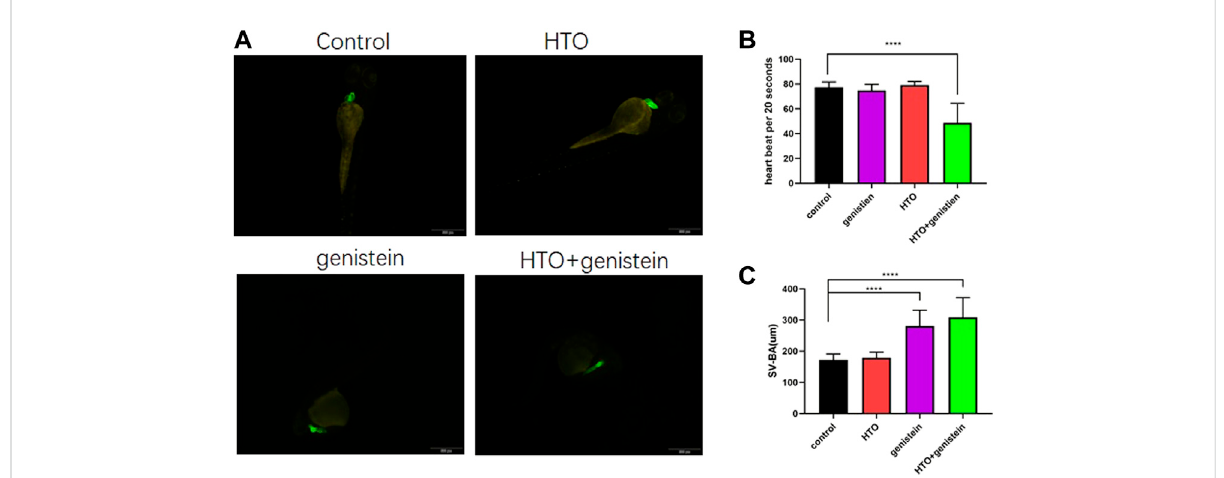
FIGURE 3 Themorphologyoftheheartofzebra fi shlarvae. (A) Themorphologyoftheheartineverygroup; (B) theheartrateofzebra fi shat96 hpf; (C) The distance between the atria and ventricles of 96 hpf zebra fi sh larvae. 10 samples were taken from each parallel samples of each experimental group. **** p < 0.0001.